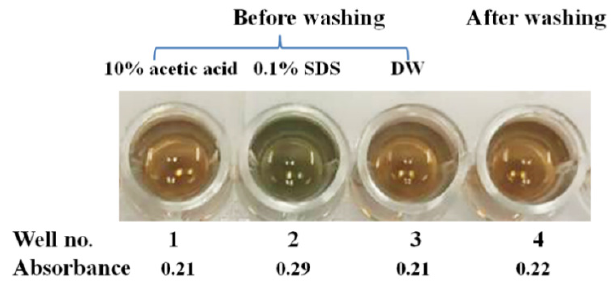
Figure 5. Developed color of the Bradford reagent towards each washing solution on NIP-coated